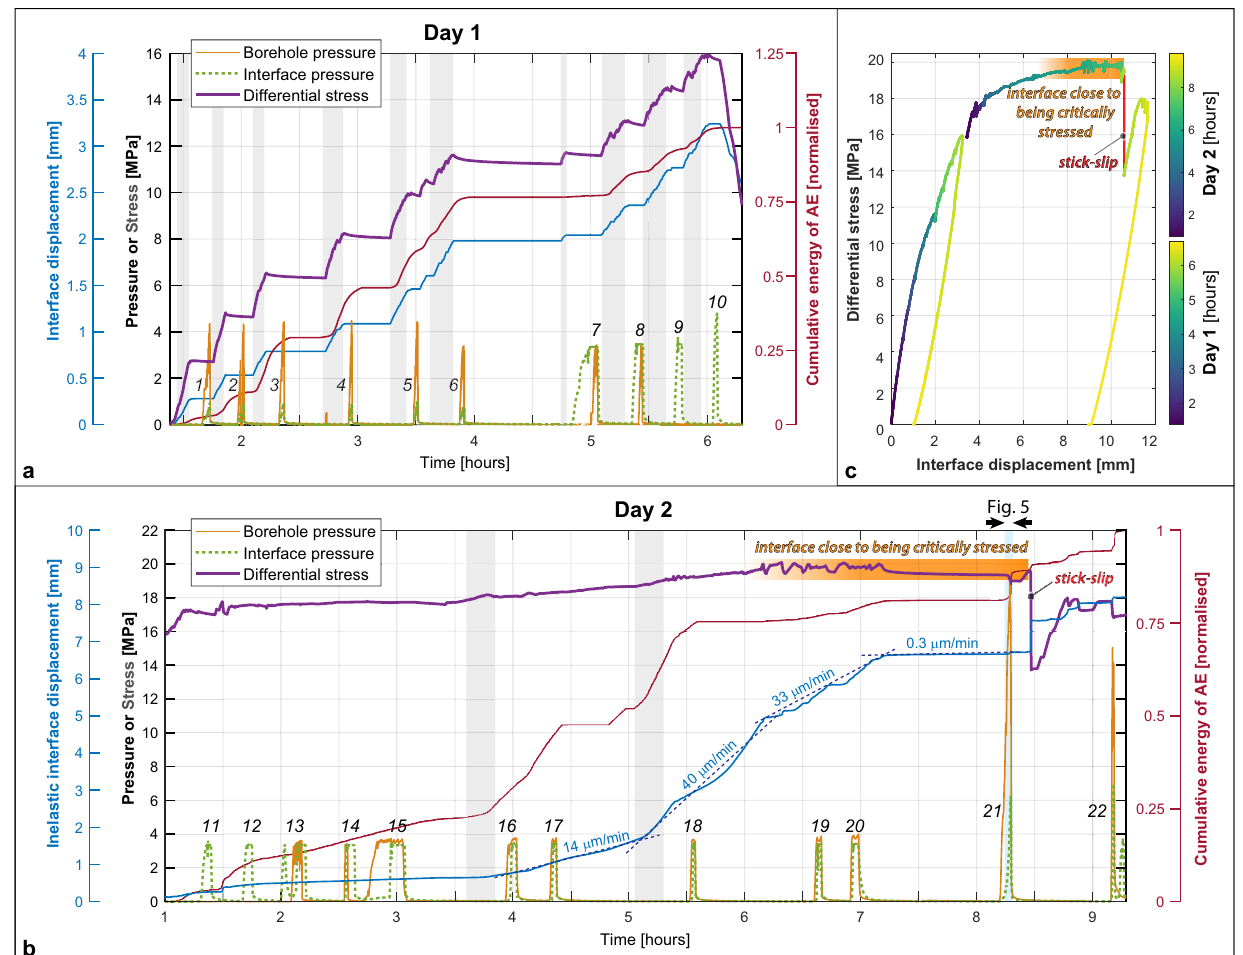
Figure 2. Overview of the 2-day testing of the Castlegate Sandstone block. ( a ) Day-1 of the AE experiment with incremental increases of the differential stress (gray shading), related release of AE energy, interface displacement/creep and borehole/interface fluid injection pressures. Injection-stages 1–10 are indicated by numbers. ( b ) Day-2 of the experiment. Gray shading shows two time intervals where differential stresses were increased by about 0.4 and 0.5 MPa, respectively, both times accompagnied and directly followed by an increase in AE activity. The interface creep rate increased to about 30–40 μm/min, until the maximum differential stress was reached and the interface continued to creep with only 0.3 μm/min. The blue shading shows the time interval of the high-pressure fluid injection, followed by related fracture creation and stick–slip movement of the whole block. ( c ) Interface displacement vs differential stress for entire experiment, day 1 stops after 6 h. Note that ( a ) and ( c ) show interface displacement, whereas ( b ) shows inelastic interface displacement in order to visualize the related displacement at the time of the